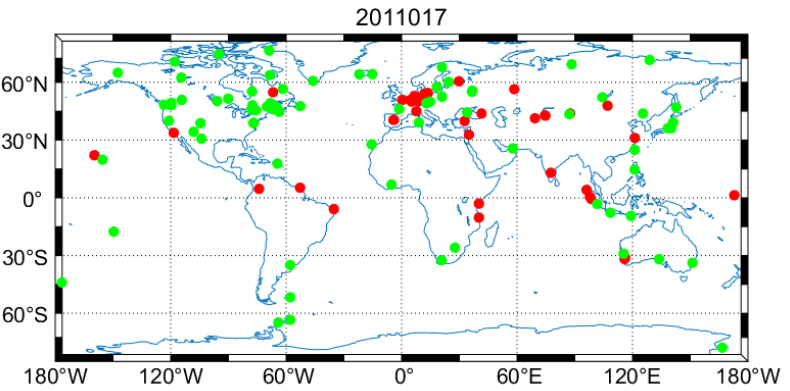
Figure 5. Global distribution of selected ground receivers in geographic frame of reference. Green dots represent reference stations while red dots represent abandoned stations in step 3 on 17th January 2011. Table 1. Numbers of discarded stations located in low, mid and high latitudes during the second half of January 2011.